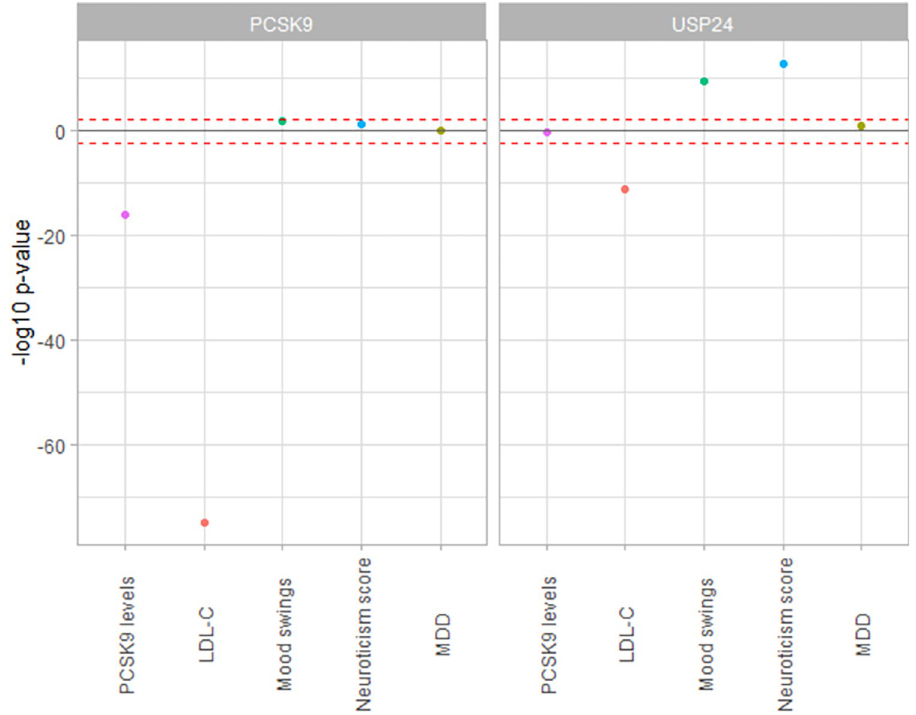
Fig 2. Cross-tissue MR association of PCSK9 and USP24 gene-expression levels with phenotypes of interest. The Y-axis represents the -log 10 p-value of the MR association, while the direction signifies the direction of effect of gene- expression reduction, which serves as a proxy for PCSK9i. MR (IVW) for PCSK9 and USP24 gene-expression with combined eQTL estimates from all available tissues in GTEx v8. The blue and red lines signify p-value of 0.05 and Bonferroni-corrected threshold for 5 traits per gene of 0.005,